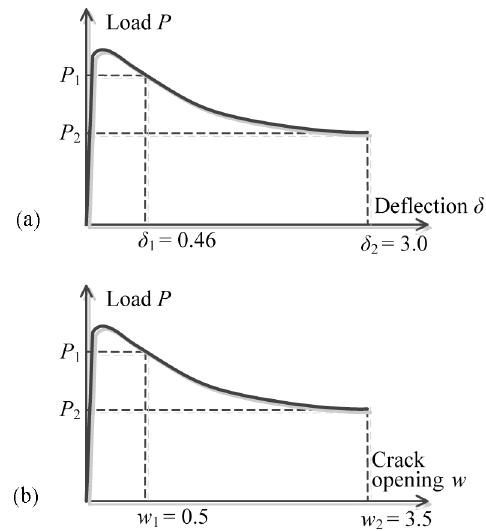
Fig. 3. Experimentally obtained load-deflection (a) and load-